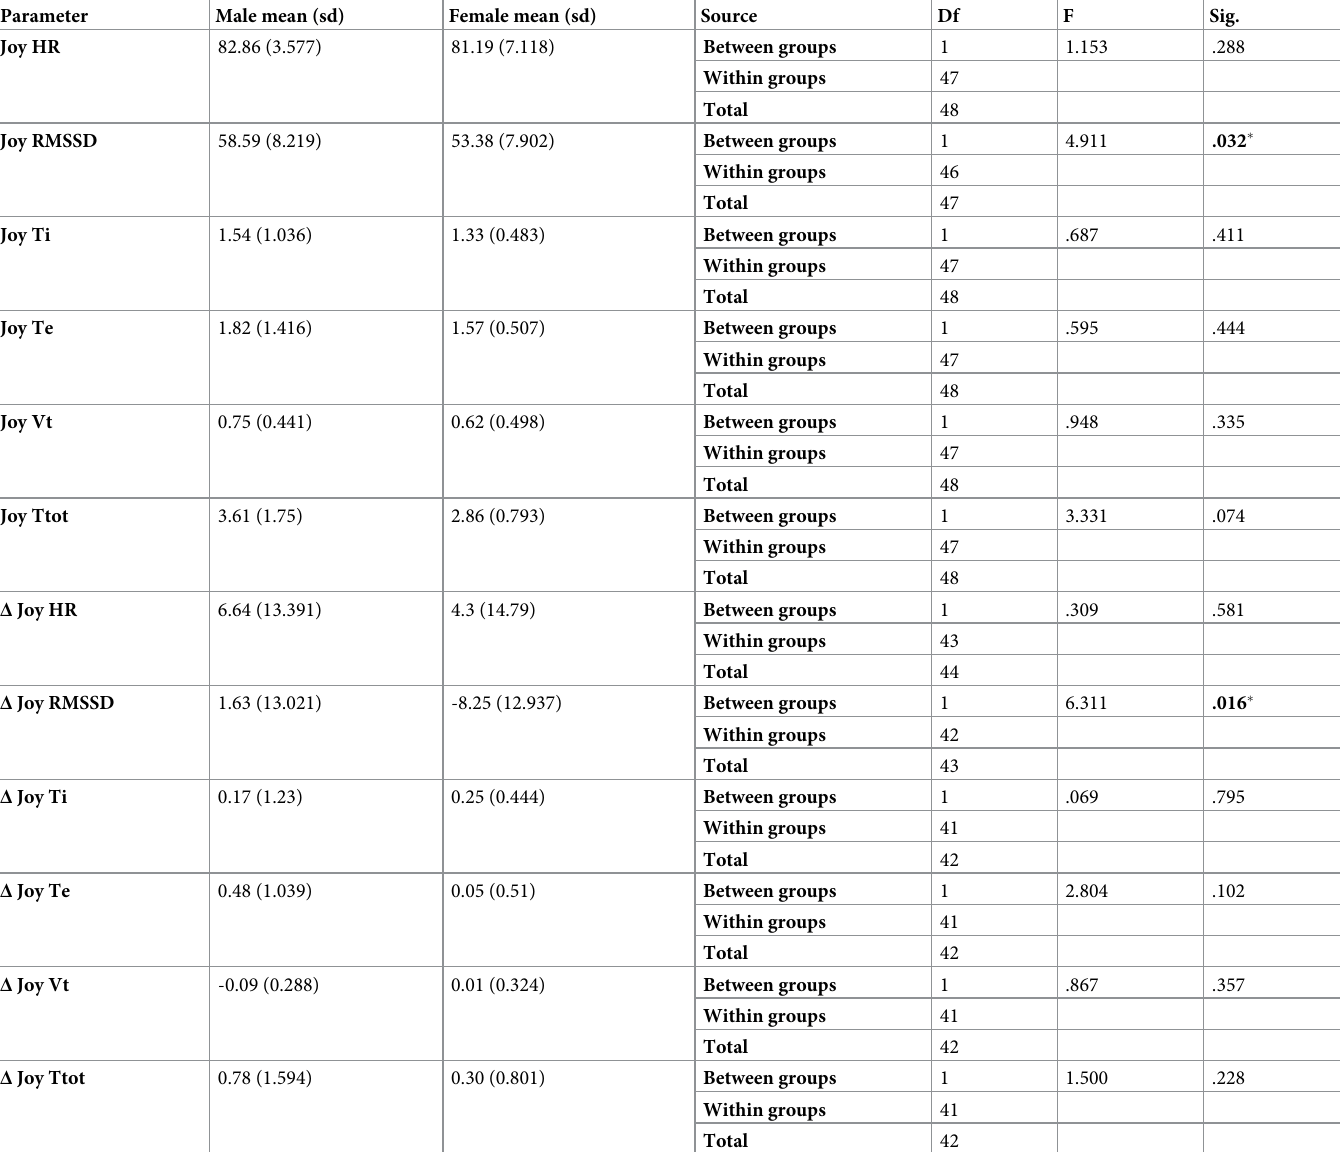
Table 4. ANOVA for autonomic (cardiac and respiratory) response and reactivity during joy of males and females. Parameter Male mean